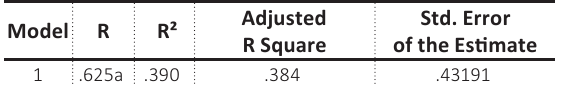
Table 3. Hypothesis 1 testing